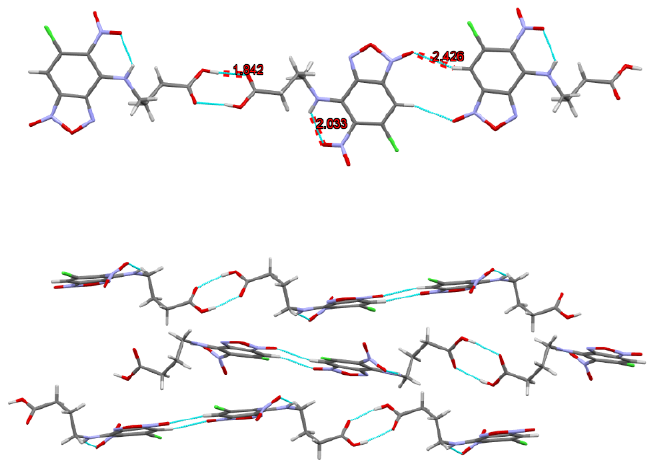
Figure 9. A packing of molecules in crystal of compound 4l . Only classical hydrogen bonds are observed.